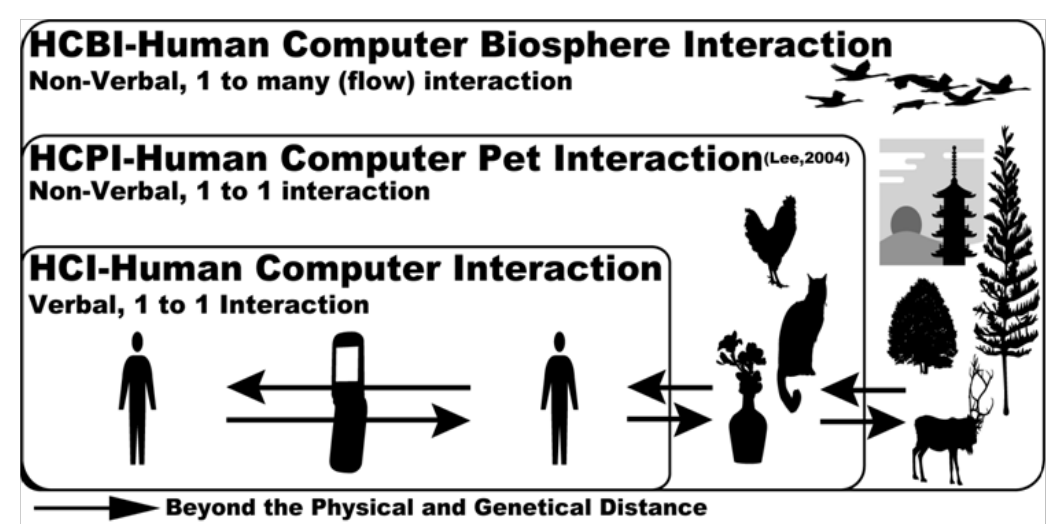
Figure 3. Human–computer–biosphere interaction (HCBI) concept [6], an extension of human–computer interaction (HCI) and human–computer–pet interaction (HCPI). Copyright 2009 Hiroki Kobayashi, with permission from